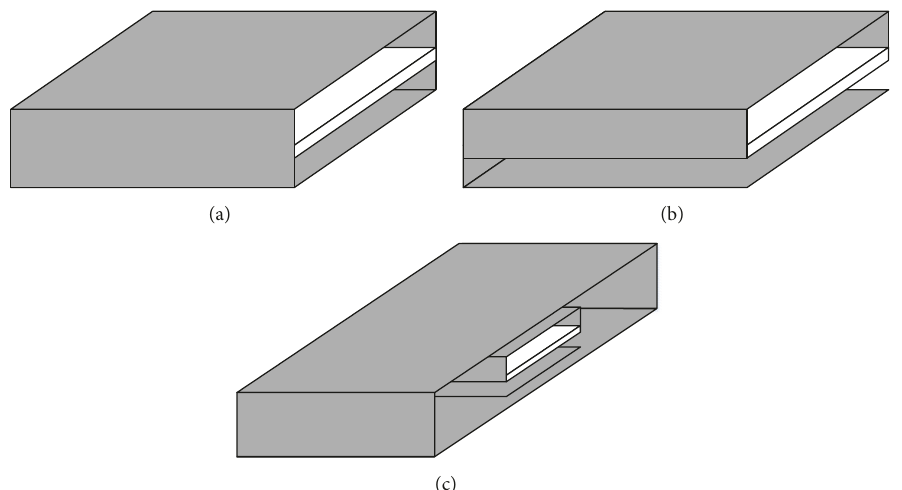
Figure 15: Antennas with three different metallic shells: (a) the front side of the metal box is removed; (b) the front side and a part of the flank of the metal box are removed; (c) two-layer metal box.